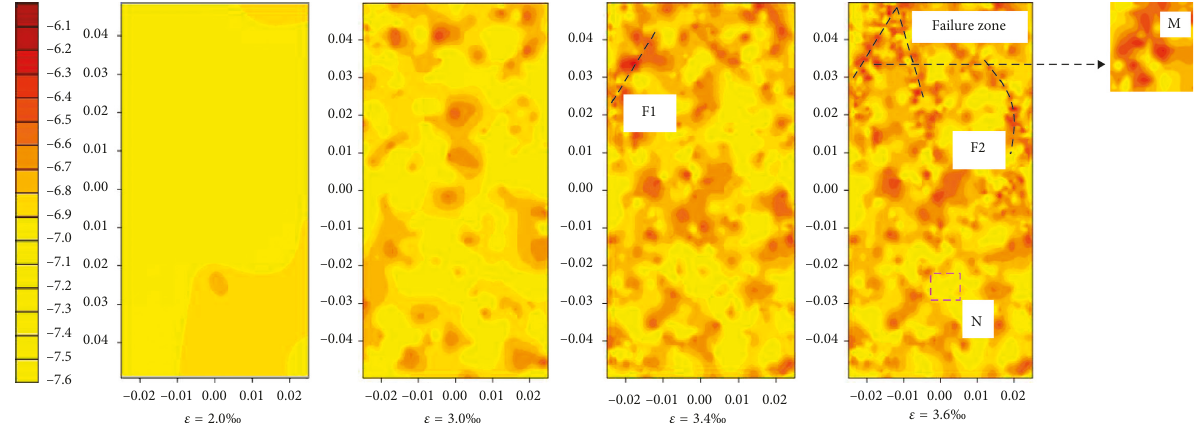
Figure 7: Moment magnitude cloud map under uniaxial compression.